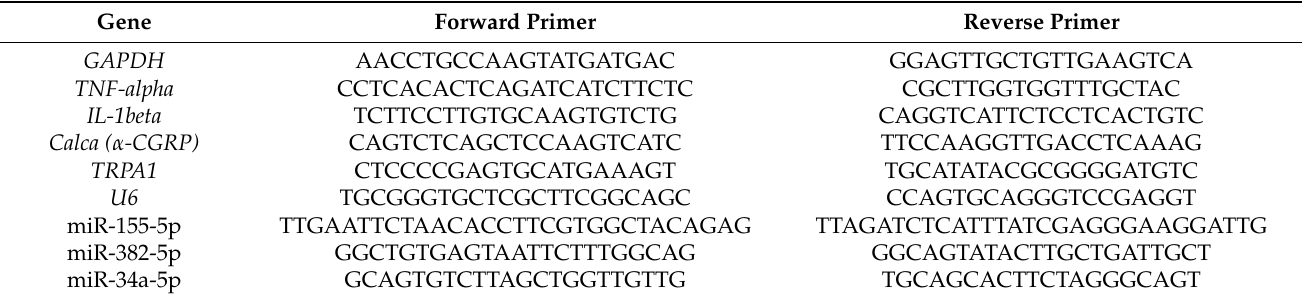
Table 2. Primer sequences used in rt-PCR